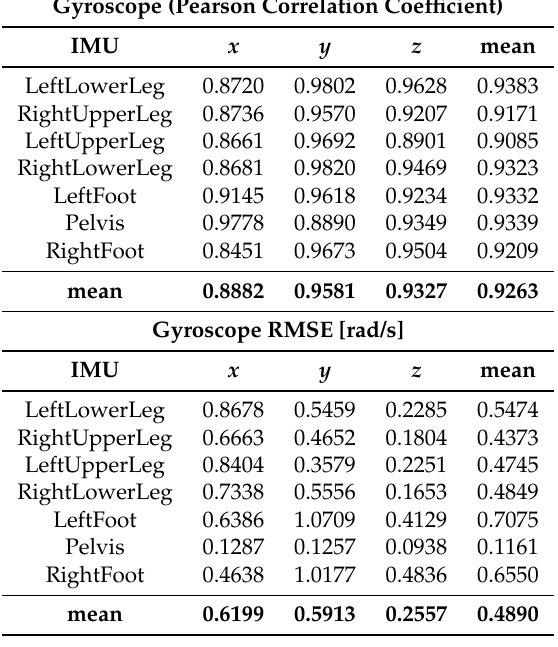
Table A5. Pearson correlation coefficients and root mean squared errors (RMSE) between real and re-simulated gyroscope data from a capturing setup where IMUs were mounted on a person during walking and were additionally tracked with a marker based optical system.